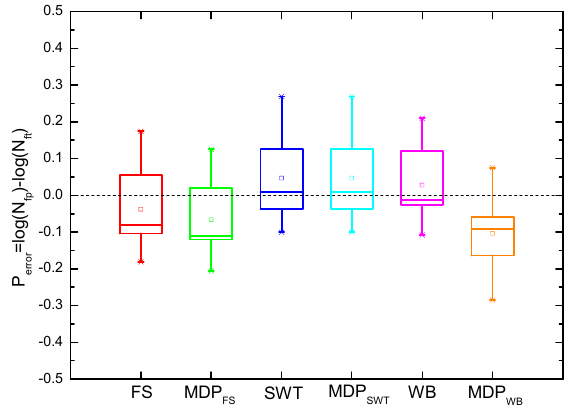
Figure 6. A comparison of uniaxial fatigue tested life and predicted life of three models for GH4169 at 650 °C.